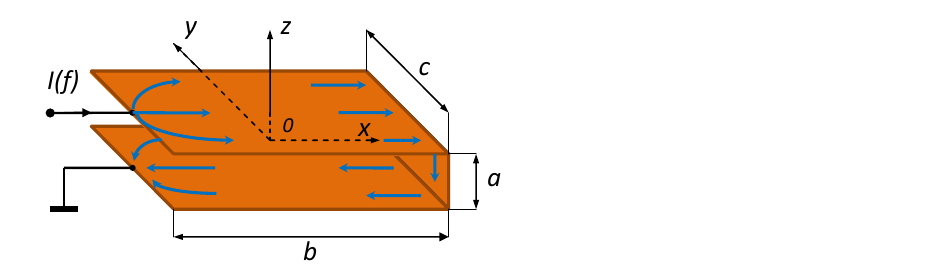
Figure 1. Schematic view of the “magnetic capacitor” excitation system. The arrows show the direction of the current in the electrodes.